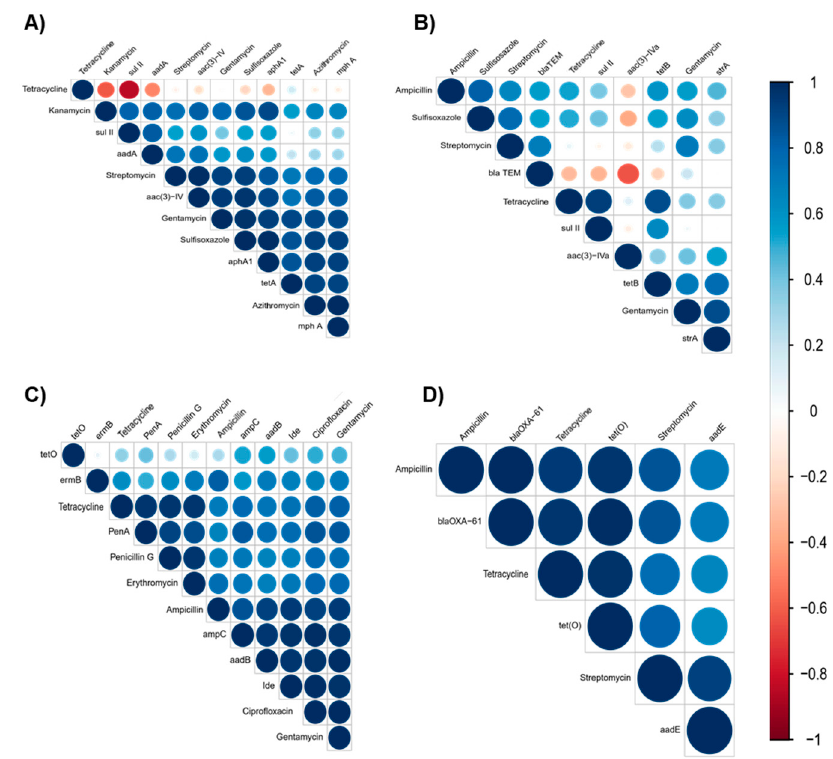
Figure 3. Correlation matrix of phenotypic and genotypic antibiotic resistance of ( A ) E. coli O157, ( B ) Salmonella , ( C ) L. monocytogenes, and ( D ) Campylobacter. Blue is positive correlation and red is negative correlation (1 = positive correlation, 0 = no correlation, and − 1 = negative correlation). Size and strength of the color represent numerical value of correlation coefficient.